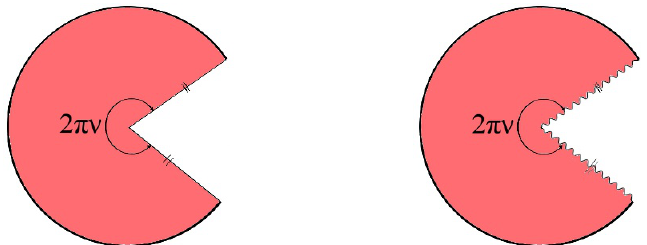
Figure 2 : Particle on AdS